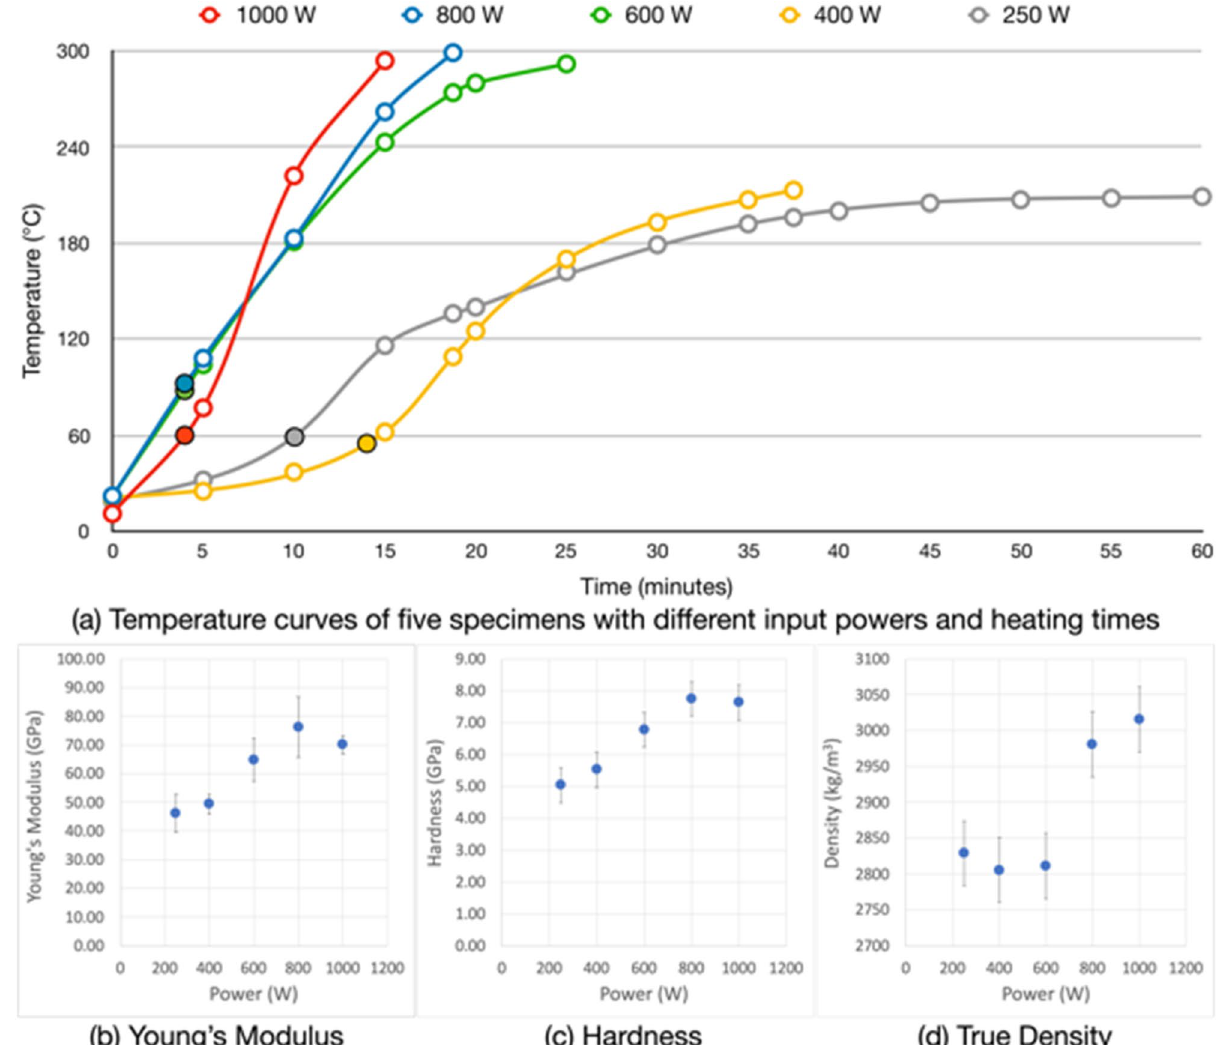
Figure 7. Temperature curves ( a ), Young’s modulus ( b ), hardness ( c ) and true density ( d ) of different input power specimen. Note that the temperatures in ( a ) correspond to the outer surface temperature of the crucible. The solid dots indicate the time when the hotspot caused by thermal runaway appeared on the crucible surface in 4 min for 1000 W, 3 min for 800 W and 600 W, 14 min for 400 W, and 10 min for 250 W specimen. The size and colour of the hotspot glow appear to reduce gradually from 1000 to 250 W. For example, the hotspot glow of the 1000 W sample was a bright yellow colour and > 2 cm in diameter, while that of the 250 W sample was a dimmed red colour with less than 1 cm diameter. The estimated temperature of the hotspot glows are between 1700 and 2200 °C depending on the sample mass and input power based on the previous numerical simulation study 14